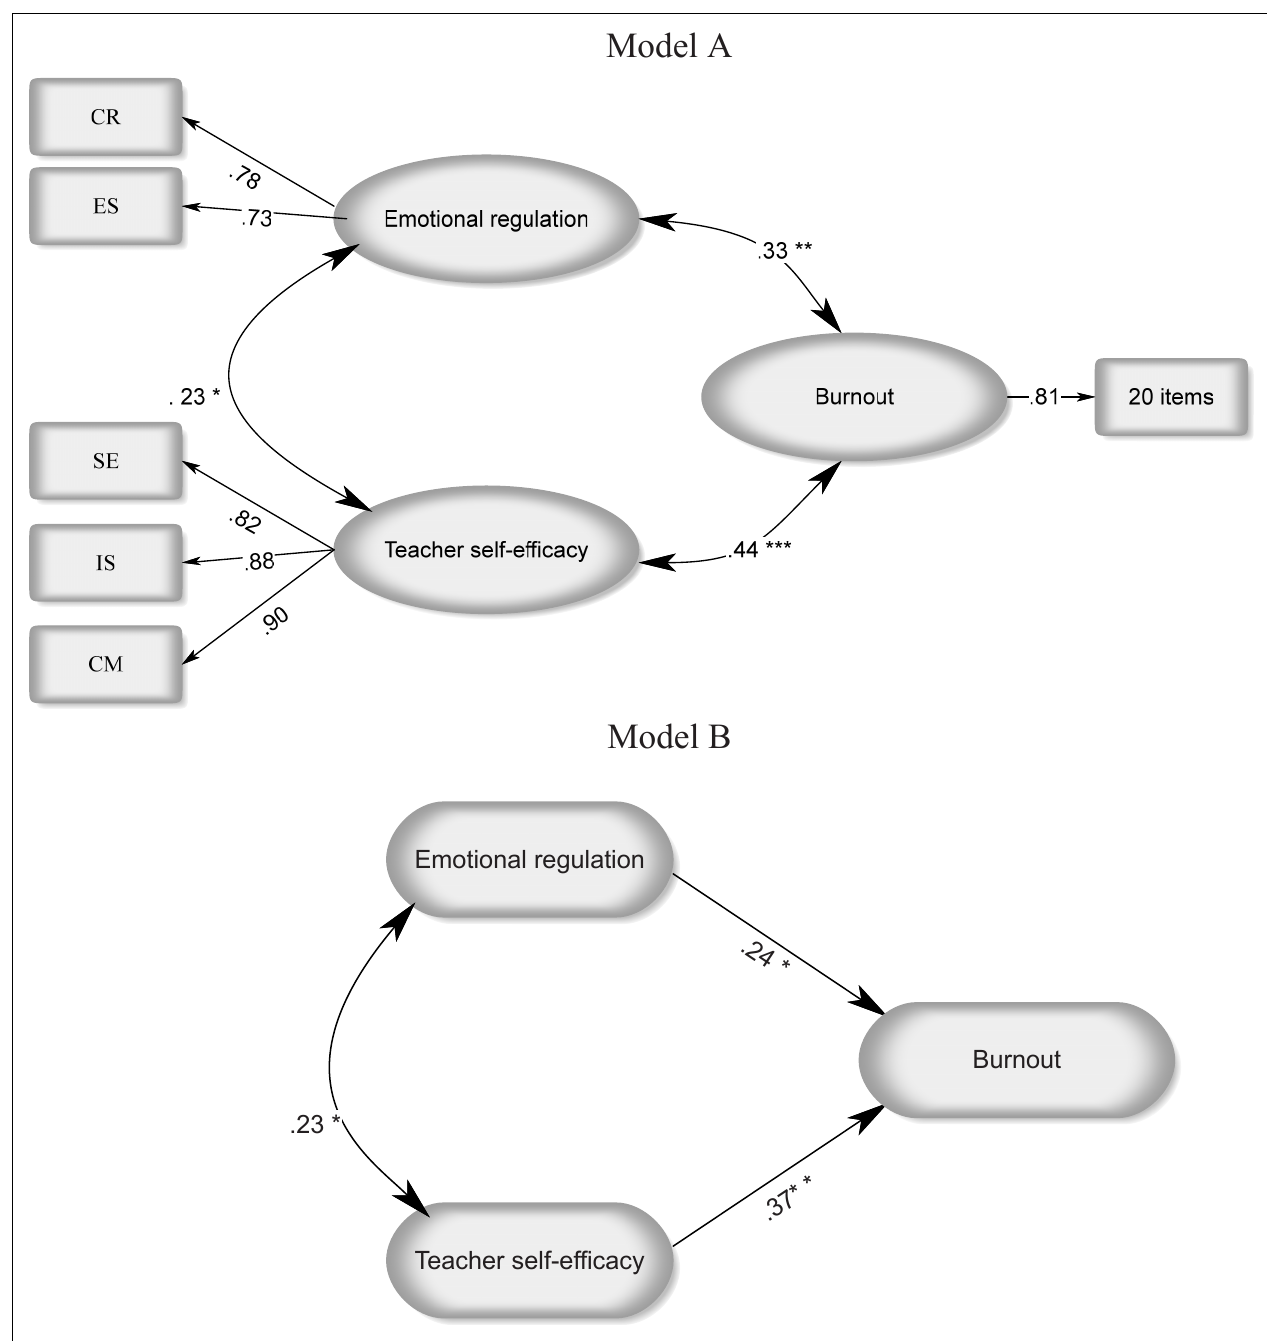
FIGURE 1 | Teacher self-efficacy and teacher emotion regulation as predictors of burnout. CR, Cognitive Reappraisal; ES, Expressive Suppression; TE, Teacher efficacy; SE, student engagement; IS, instructional strategies; CM, classroom management. *p < 0.05, **p < 0.01, ***p <